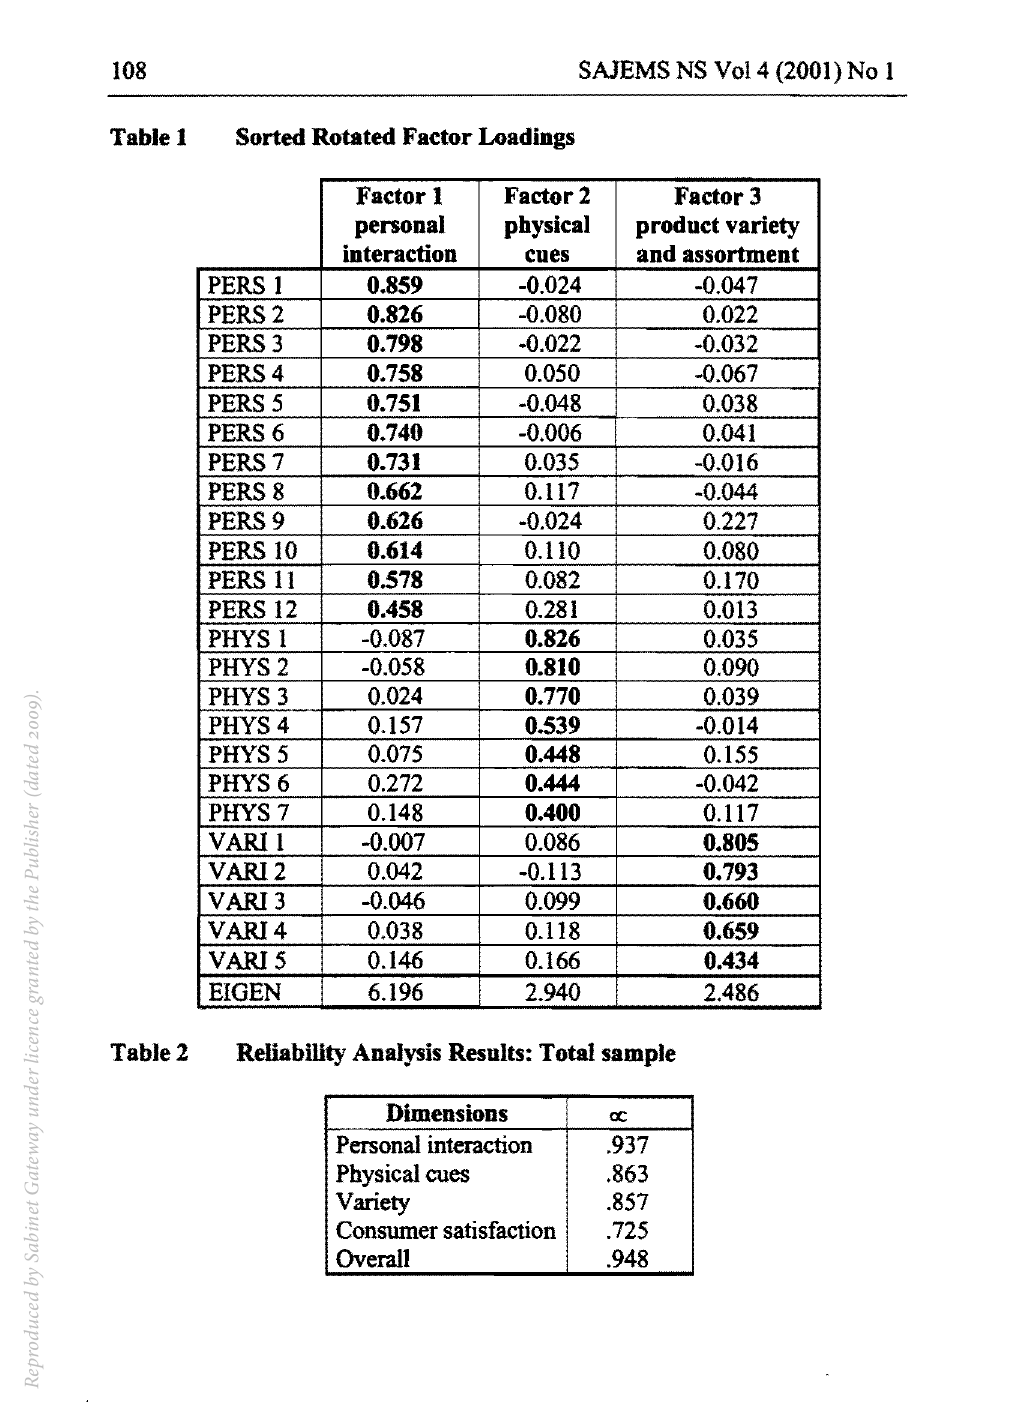
Reliability Analysis Results: Total